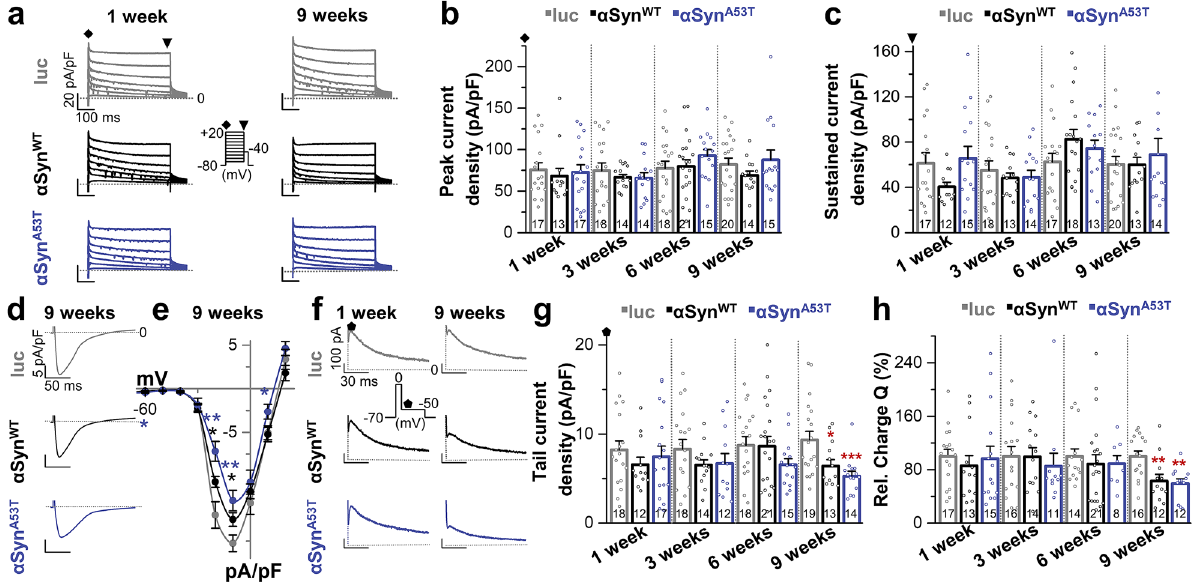
Figure 2. rAAV mediated αSyn A53T overexpression induces alterations of Ca 2+ - and small conductance Ca 2+ - activated K + currents in LC neurons. ( a ) Averaged whole-cell voltage clamp recordings of K + currents 1 and 9 weeks post-injection activated by a voltage protocol with 500 ms steps ranging from − 70 to + 20 mV starting from a holding potential of – 80 mV. ( b ) Peak current densities of I A were ascertained from the start of each voltage step (indicated by rhombus in a ) and quantified for each time-point after injection of viral vectors. ( c ) Peak current densities of I sus were ascertained from the end of each voltage step (indicated by triangle in a ). For I sus current recordings the membrane potential was depolarized to − 40 mV for 100 ms prior to voltage steps to remove I A current components. ( d ) Average of Ca 2+ current recordings 9 weeks after injection of viral vectors derived from a voltage step to − 10 mV. ( e ) I/V relationships of peak Ca 2+ currents 9 weeks after injection, using the same voltage protocol as in ( a ). Ca 2+ currents were significantly reduced 9 weeks post-injection in both αSyn WT and αSyn A53T injected mice (luc: n = 14, αSyn WT : n = 28, αSyn A53T : n = 12). ( f ) Representative I